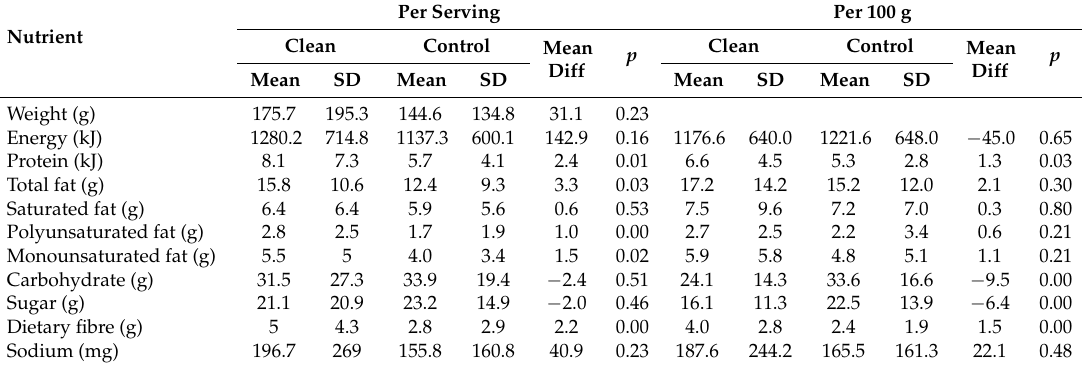
Table 2. Comparison between clean eating recipes and controls per serving and per 100 g. Per Serving Per 100 g Nutrient Clean Control Mean p Clean Control Mean Diff